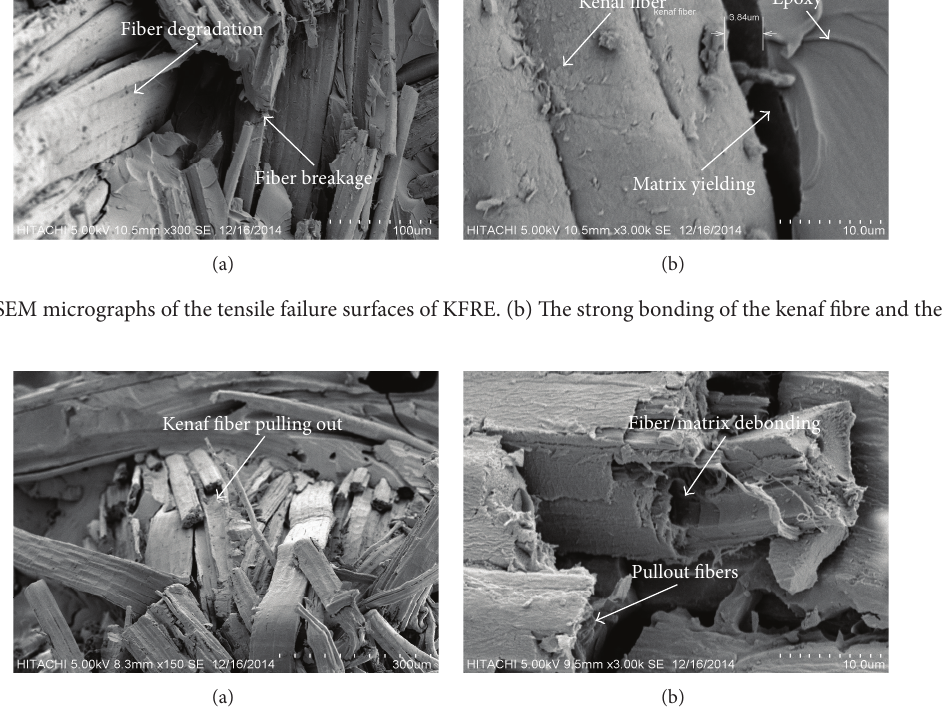
Figure10:(a)TheSEMmicrographsofthetensilefailuresurfacesofKFRP.(b)Bondingareaofthewovenkenafwiththeunsaturatedpolyester